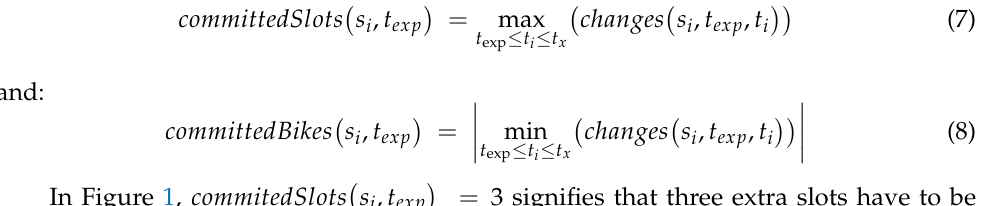
Figure 1. Example of the evolution of the number of bikes at a station. Values of changes (cid:0) (cid:1) , 𝑡, 𝑡 (cid:3439) , 𝑐𝑜𝑚𝑚𝑖𝑡𝑒𝑑𝐵𝑖𝑘𝑒𝑠(cid:3435)𝑠 𝑐ℎ𝑎𝑛𝑔𝑒𝑠(cid:3435)𝑠 s i , t exp and commitedSlots are (cid:3036) (cid:3032)(cid:3051)(cid:3043)